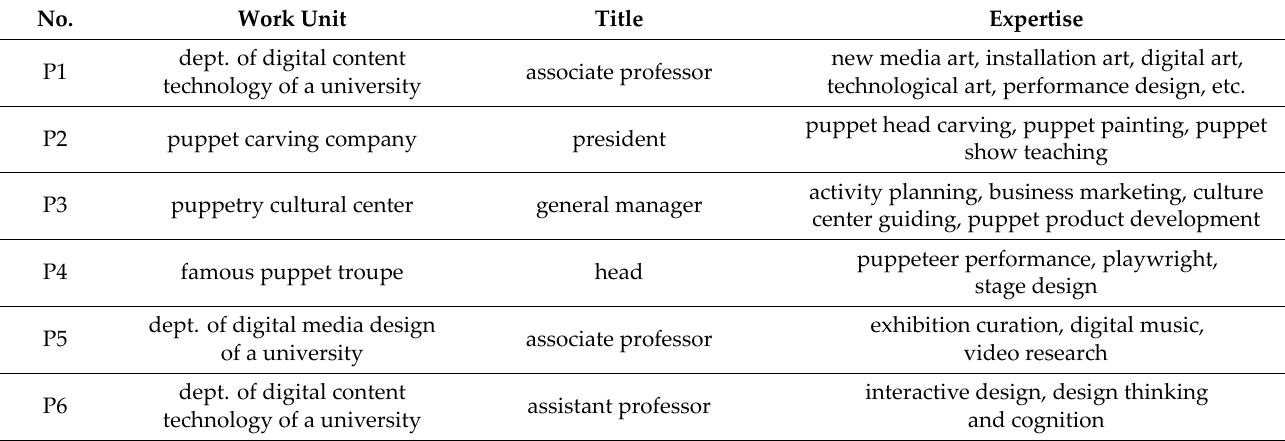
Table 4. Brief introductions to the six experts invited to use the system and accept